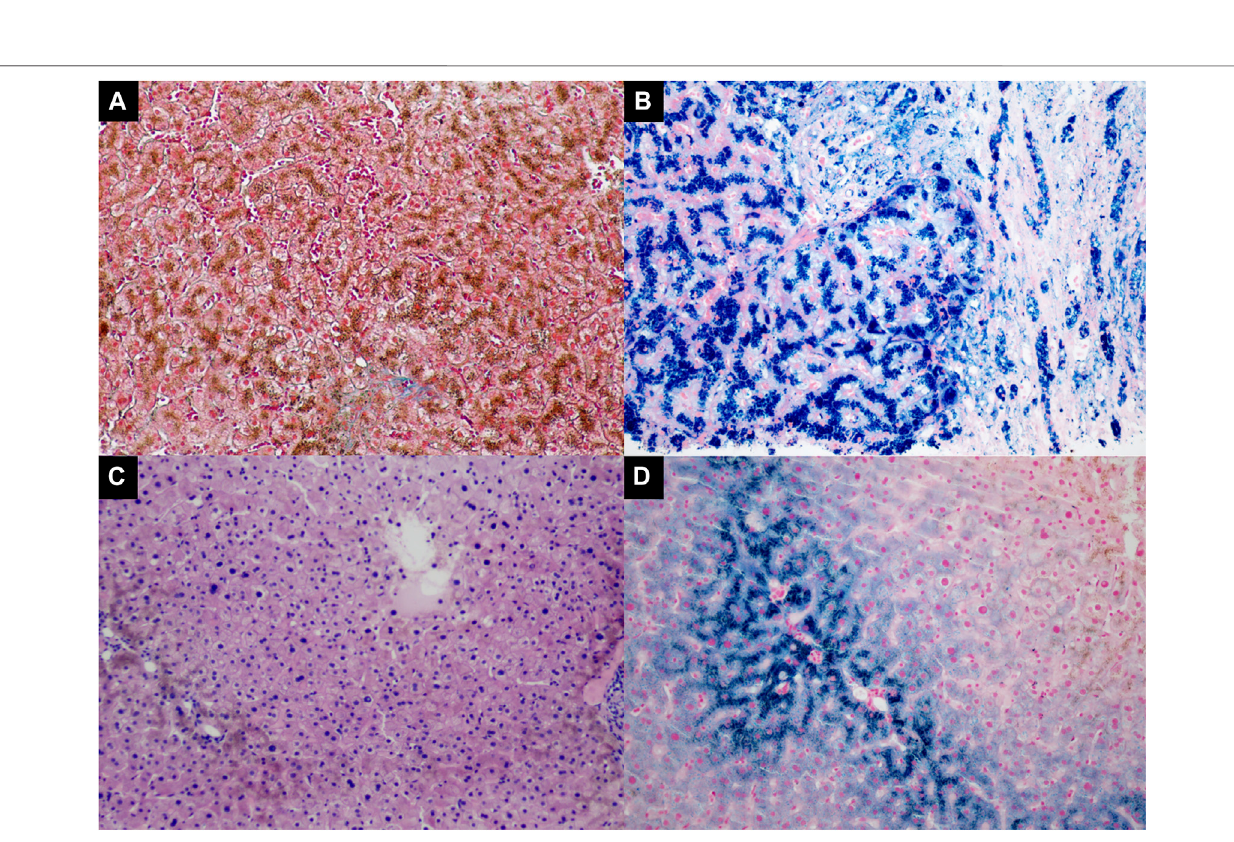
Frontiers in Genetics |